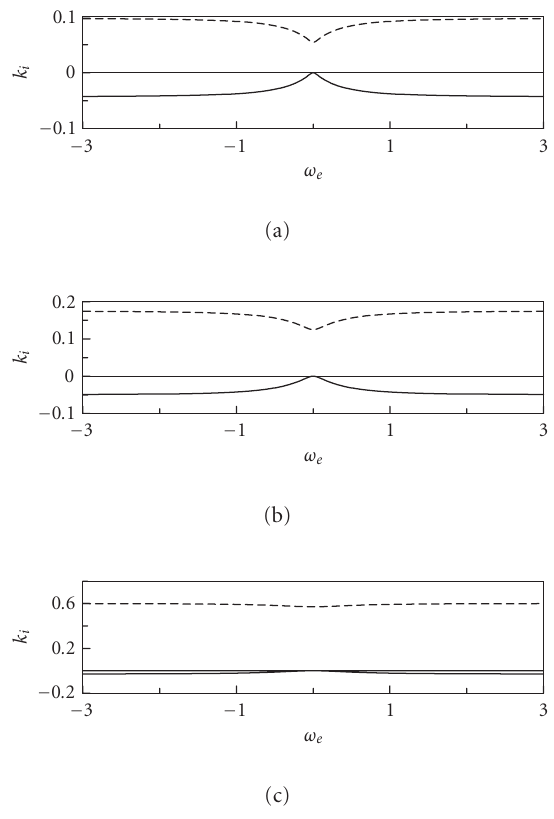
Figure 4.1. Imaginary part of the wave number. The solid line represents unstable wave and the dashed line represents evanescent wave. (a) F = 7 . 5, (b) F = 5, and (c) F = 2 .